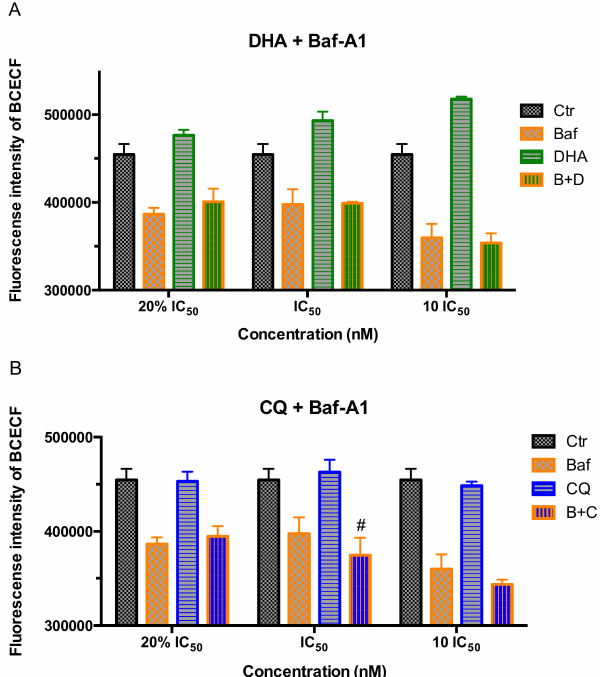
Figure 5. The fluorescence intensity of parasites in trophozoite stage P. f 3D7 staining with pH probe BCECF, AM after 2 h of combination drug treatment with a series dose of antimalarial drugs DHA / CQ and V-ATPase inhibitor Baf-A1 by flow cytometry. ( A ) Fluorescence intensity of BCECF in trophozoite stage P. f 3D7 treated by DHA combined with Baf-A1; ( B ) Fluorescence intensity of BCECF in trophozoite stage P. f 3D7 treated by CQ combined with Baf-A1. Ctr means control, B + D means DHA combined with Baf-A1, B + C means CQ combined with Baf-A1. Data shown are mean ± SEM (n ≥ 3). # p < 0.05 vs.